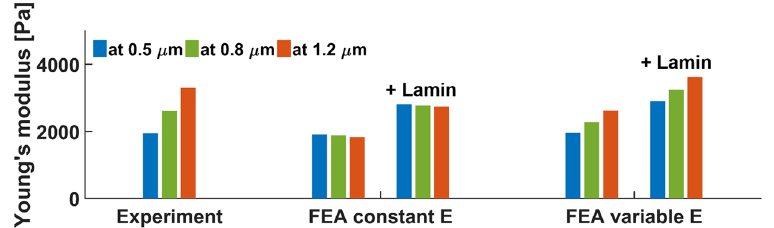
Figure 3. Modelling the spatial variation of the nucleus stiffness. Left: The experimental values, show a rise of E * at increasing deformation (the response at 15 nN is not shown because the resulting high deformation proved to be very difficult to simulate numerically). Middle: When the nucleus is modelled with FEA as a sphere with a constant Young’s modulus, the calculated values after analysis are nearly constant. Adding a stiff external layer, representing the nuclear lamina increases the absolute stiffness but does not introduce the deformation length-scale dependency. Right: Here, the modelled nucleus has a Young’s modulus that linearly decreased from the centre to the periphery (from 10 to 0.3 kPa). The analysed values for E now increase with the deformation length-scale, similar as the experimental values. This is independent of the nuclear